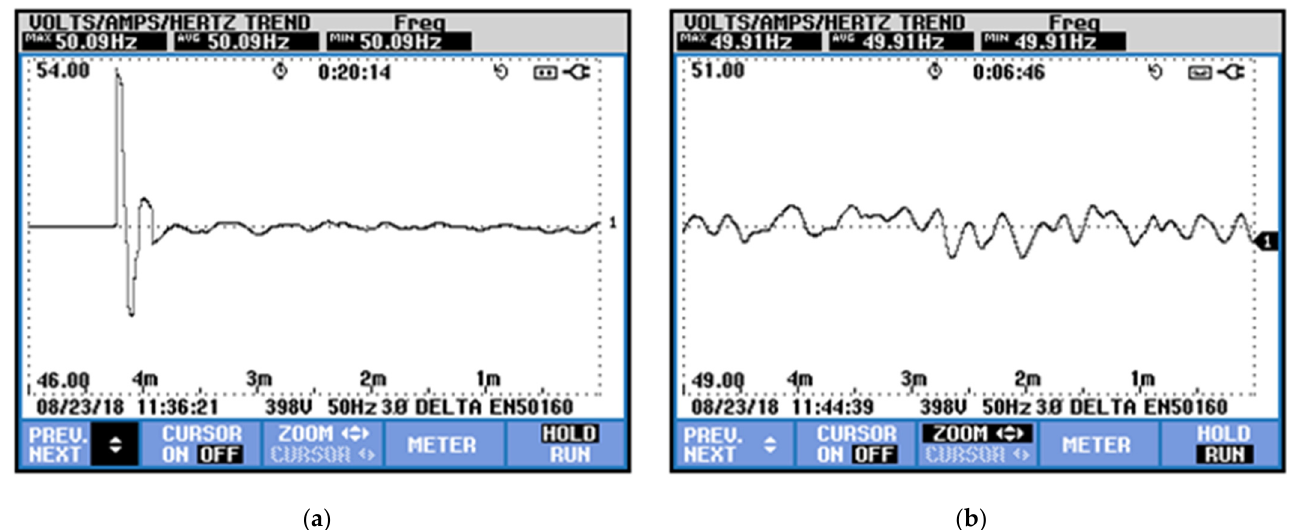
Figure 14. ( a ) Frequency results in the Soft Interchange Control Step (SIPQC); ( b ) THD Current result in the AC offshore link grid—CIS Control.